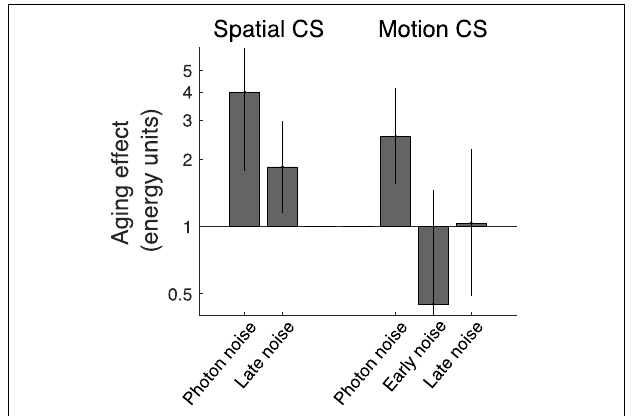
FIGURE 2 | Impact of healthy aging on components of the visual system assessed using a novel noise paradigm for spatial contrast sensitivity (left; Silvestre et al., 2019) and motion contrast sensitivity (right; Braham chaouche et al., 2020). The photon noise represents the variability in the number of photons detected by cones and directly reflects the number of photons detected by cones (i.e., when contrast sensitivity is proportial to the square root of the luminance intensity (de Vries-Rose law). The early noise represents the impact of the dominant noise source for conditions under which contrast sensitivity is proportional to luminance intensity (linear law). The late noise represents the impact of the dominant noise source for conditions under which contrast sensitivity is independent of luminance intensity (Weber’s